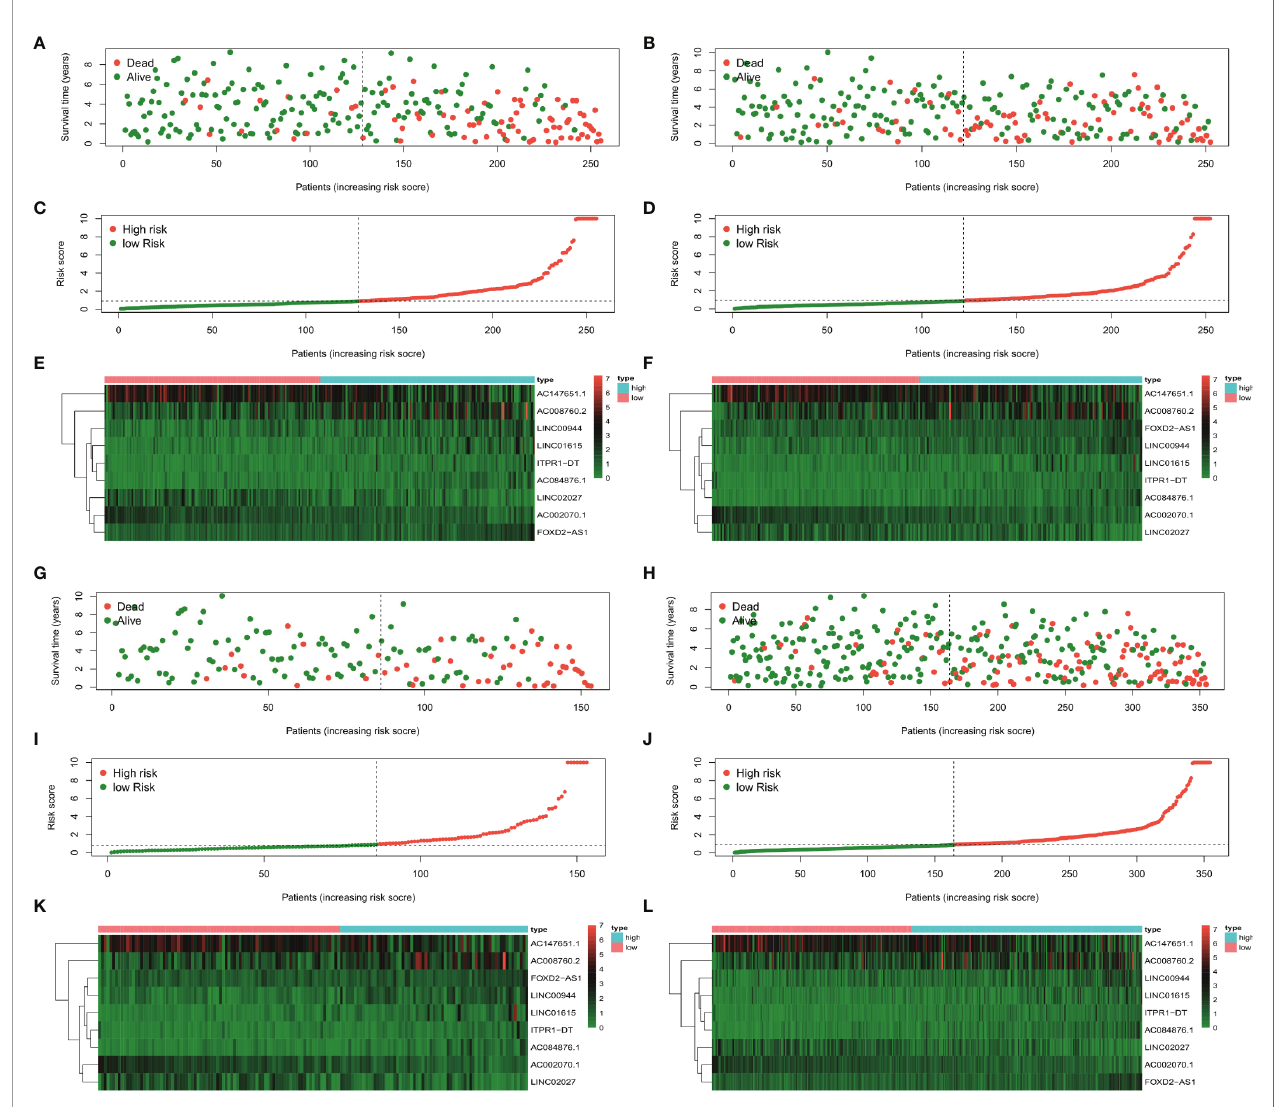
FIGURE 5 | The survival status, risk score distribution, and risk lncRNA expression in the datasets. (A, C, E) Training dataset, (B, D, F) 1 st validation dataset, (G, I, K) 2 nd validation dataset, and 3 rd validation dataset (H, J, L)